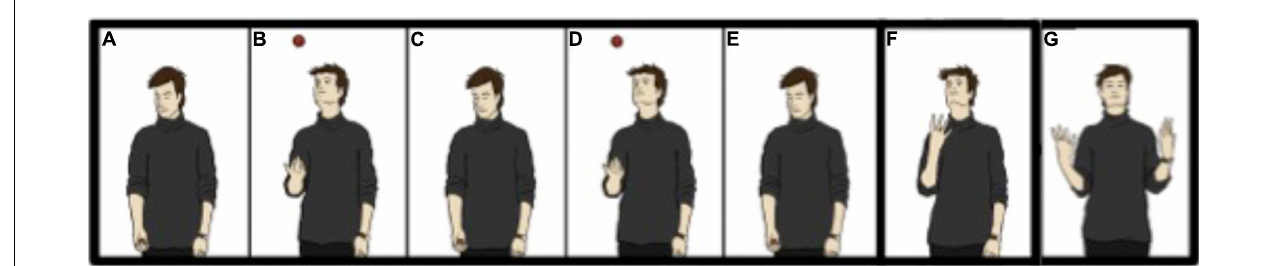
FIGURE 1 |TheVanishing Ball: (A)The magician is holding a small ball. (B–E) He throws the ball in the air twice, following its trajectory with his gaze. (F) He pretends to throw the ball, but actually retains it in his hand; mean-